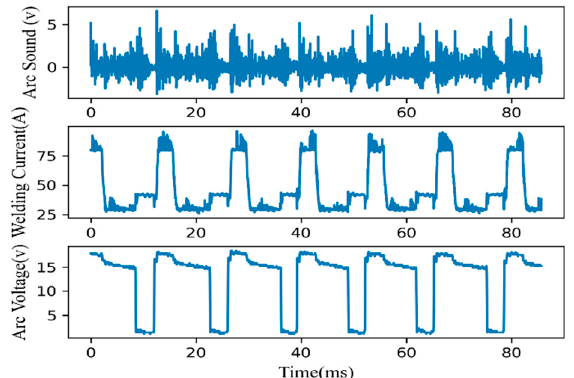
Figure 5. CMT arc sound, current, and voltage.